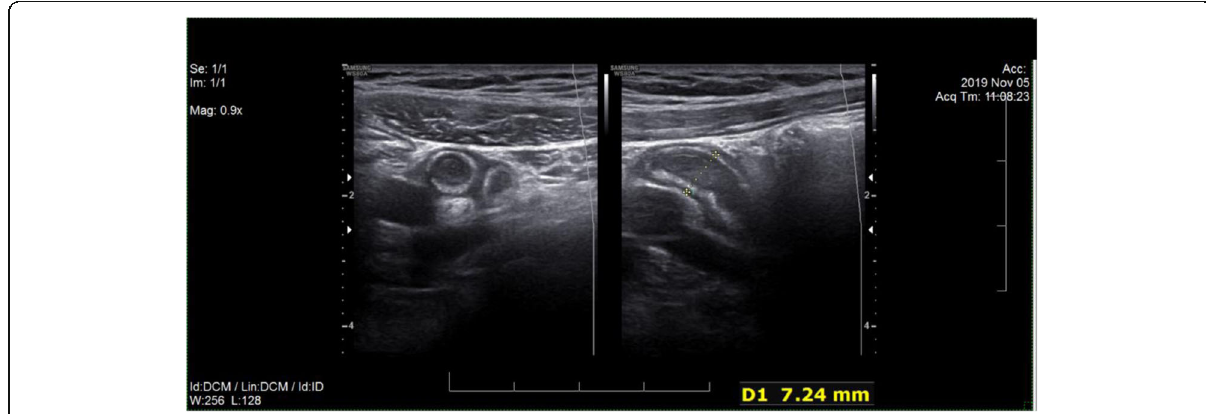
Fig. 2 Non-compressible blind loop with A-P diameter more than 6 mm and target shape at its transverse view with adjacent hyper echogenicity of peripheral fat and luminal distention is noted which showed increased blood flow around the blind loop in color Doppler study in favor of